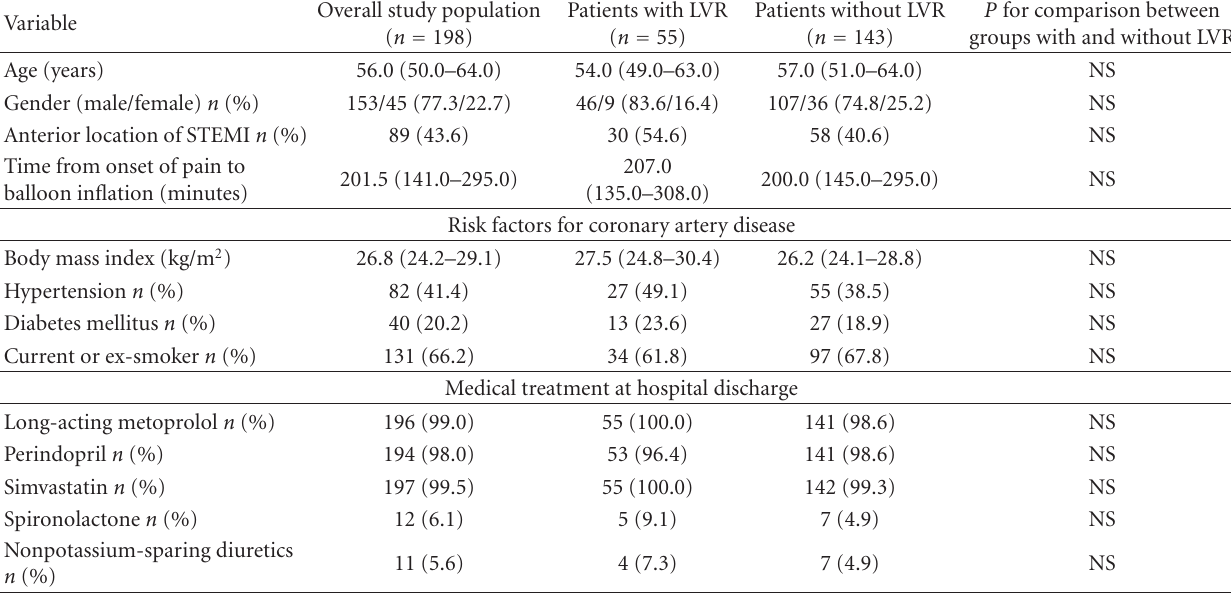
Table 1: Demographic and clinical characteristics of the study